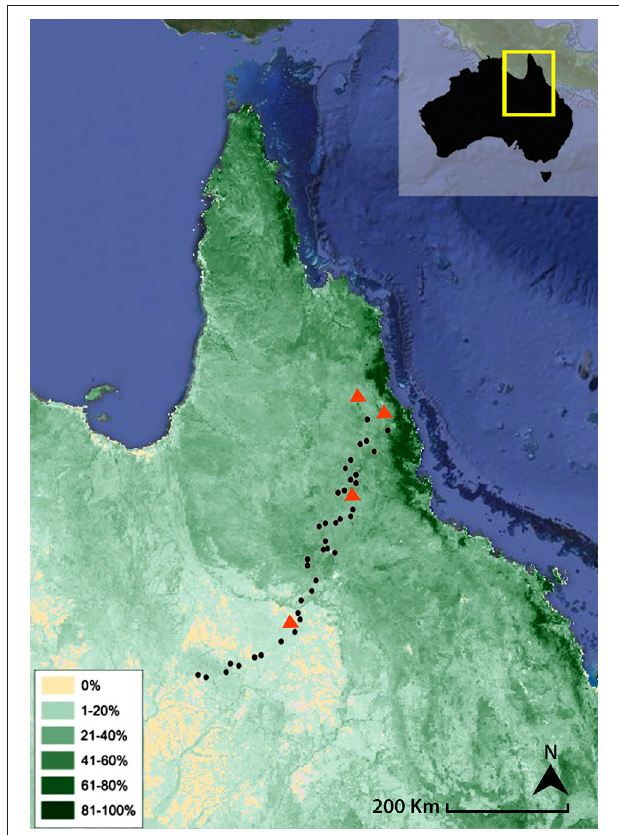
FIGURE 1 | Map showing the relative distribution (%) of green perennial vegetation in northeast Australia. Land cover data is derived from VegMachine ® CSIRO ( Karfs et al., 2004). Dots represent the farm dams on which superficial sediment was sampled, while triangles denote the locations of the experimental